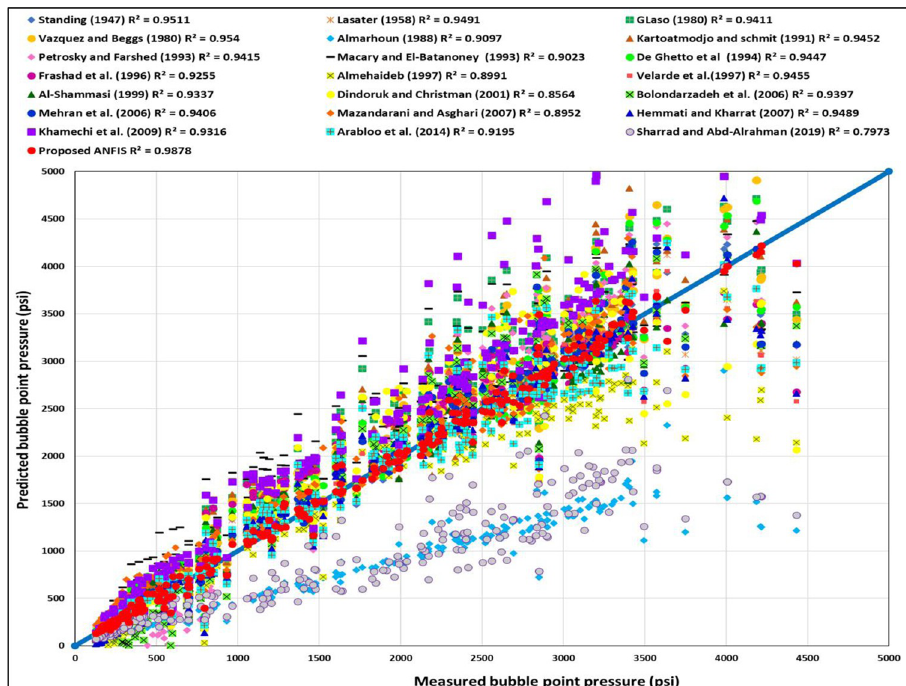
Fig 15. Cross-plot of the ANFIS and existing